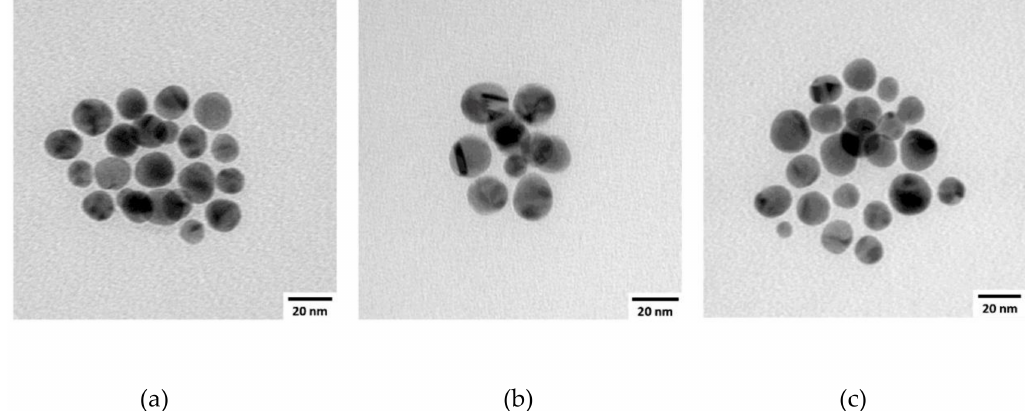
Figure 7. TEM images of three different aggregates of AuNP3 after passivation of their surface with avidin followed by addition of an excess of biotinylated nanoparticles. The cluster of nanoparticles surrounding a central one is clearly visible. Conditions for the experiment: ( a ) a solution of AuNP3 is treated with a large excess (1:8) of avidin that saturates their surface; ( b ) the unbound protein is then removed through three centrifugation/washing cycles; ( c ) a fresh solution of AuNP3 is added (final ratio AuNP3/avidin is 8:1) and the TEM images are